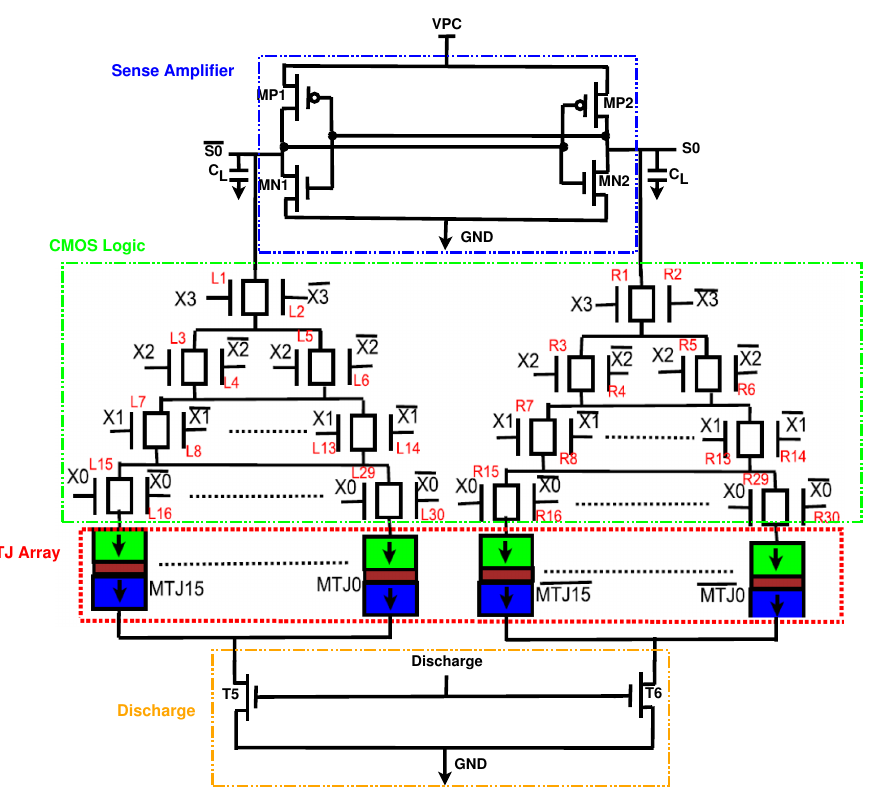
Figure 12. Proposed EE-ACML Look-Up-Table